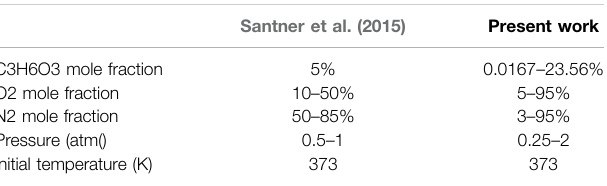
TABLE 2 | Mixture Conditions. The balance gas is